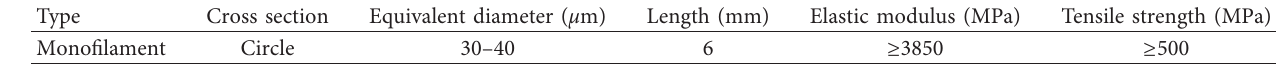
Table 6: Technical indicators of the accelerator, defoamer, and dispersant.